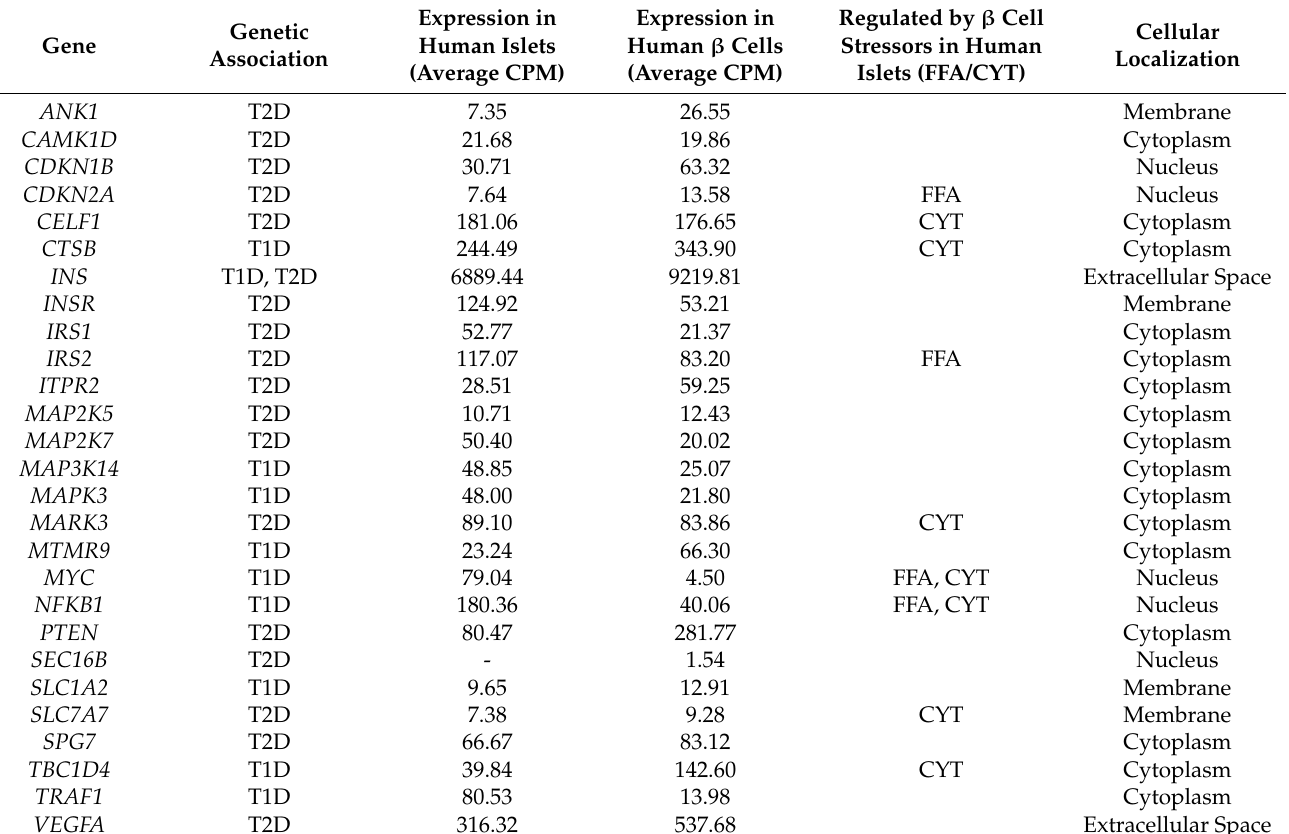
Table 1. Autophagy-related genes genetically associated with T1D and T2D. Human autophagy- related genes were extracted from the Human Autophagy Database on 18 March 2023 (http://autophagy.lu/) and the Autophagy Database on 18 March 2023 (http://www.tanpaku.org/ autophagy/) and checked for the genetic association to T1D and/or T2D based on the most recent GWAS meta-analyses [132,174]. Expression levels are shown as counts per million (CPM) in human islets and FACS-sorted human β cells based on data from previously published studies [175–177]. A CPM > 1 was used as the cut-off level for expression. Regulation by free fatty acids (FFA) and/or pro- inflammatory cytokines (CYT) was based on previously published studies in human islets